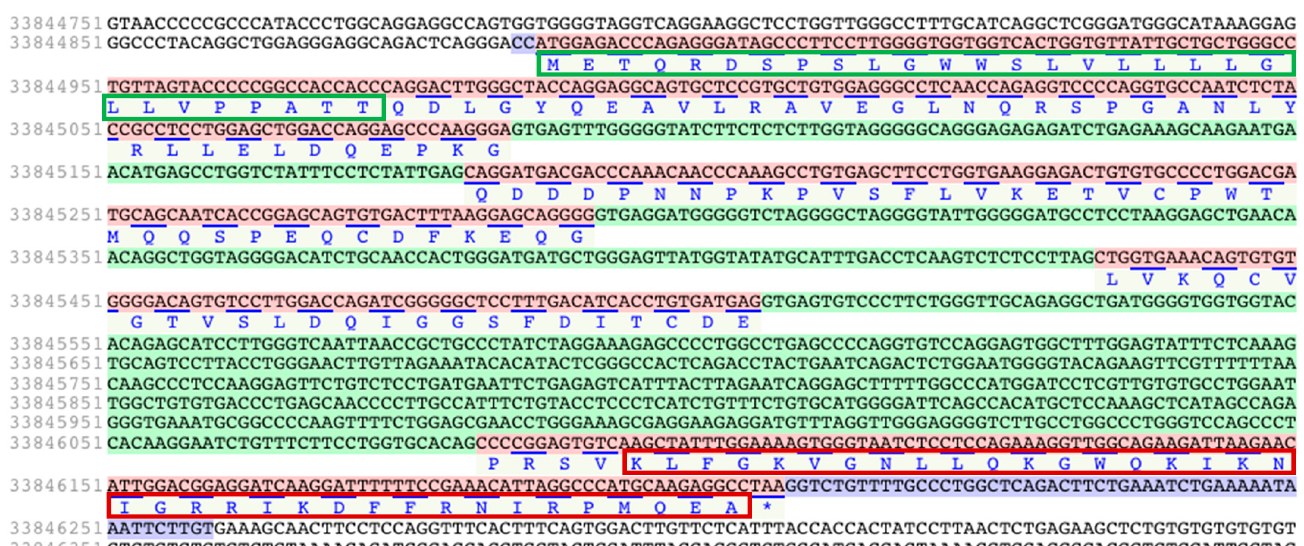
Figure 3. Alignment performed with the Constraint-based alignment COBALT [17] tool of the amino acid sequence of exons 1-3 of NBCI-annotated cathelicidins (accessed on May 2022) from the Eulipotyphla order. Sequences comprise the Iberian desman ( Galemys pyrenaicus ), the European hedgehog ( Erinaceus europaeus ), the common shrew ( Solex araneus ), the star-nosed mole ( Condylura cristata ) and the Iberian mole ( Talpa occidentalis ). Identical amino acids among all sequences are highlighted in red.